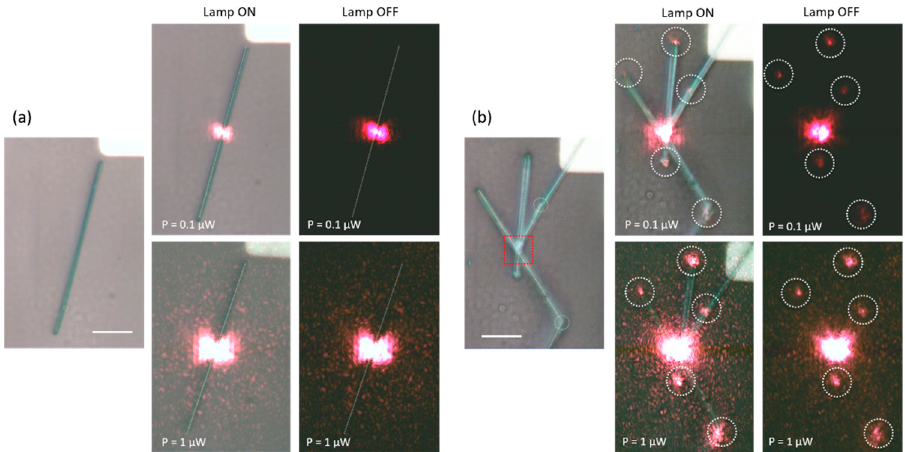
Figure 2. Light propagation in an individual ( a ) straight and ( b ) multi-branched SnO 2 NWs where the laser beam has been directed to the center of the NW and to a node, respectively. For each panel, bright (lamp ON) and dark (lamp OFF) images are shown, as functions of the incident laser power (as indicated). Light does not propagate in the straight NW illuminated in its center ( a ), whereas by illuminating a node ( b ), we observed bright spots at the end of each NW branch. This effect is amplified with increasing incident light intensity, thus showing waveguide effects. The scale bar is 5 μ m.